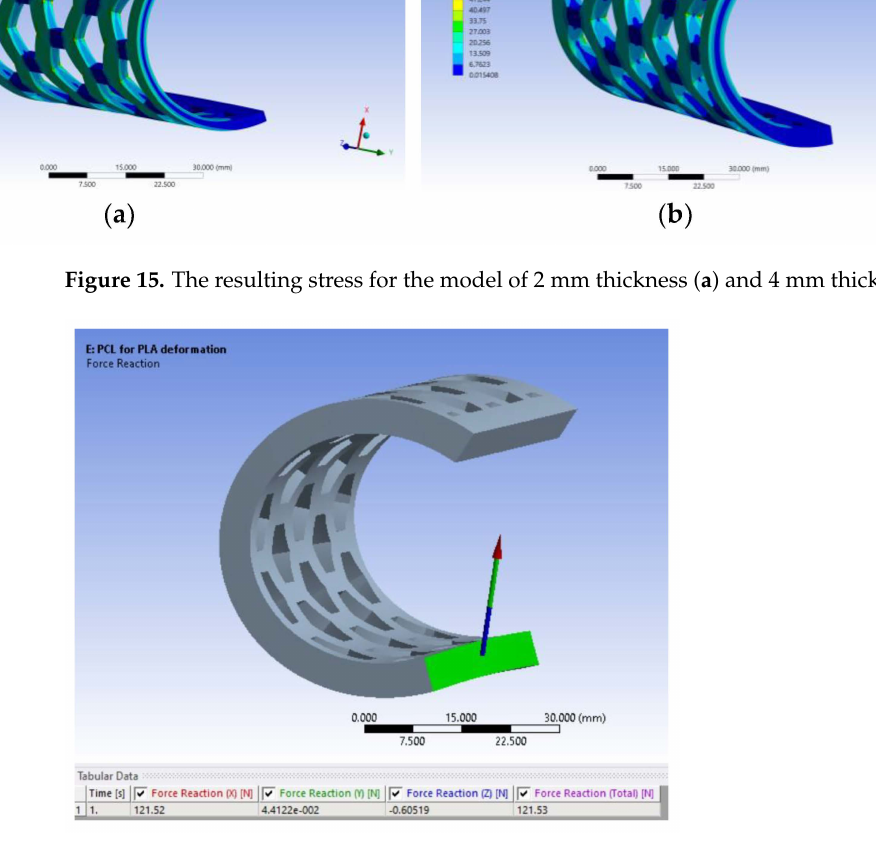
Figure 16. The 4.9 mm thick PCL sample providing similar stiffness as the 3 mm thick PLA